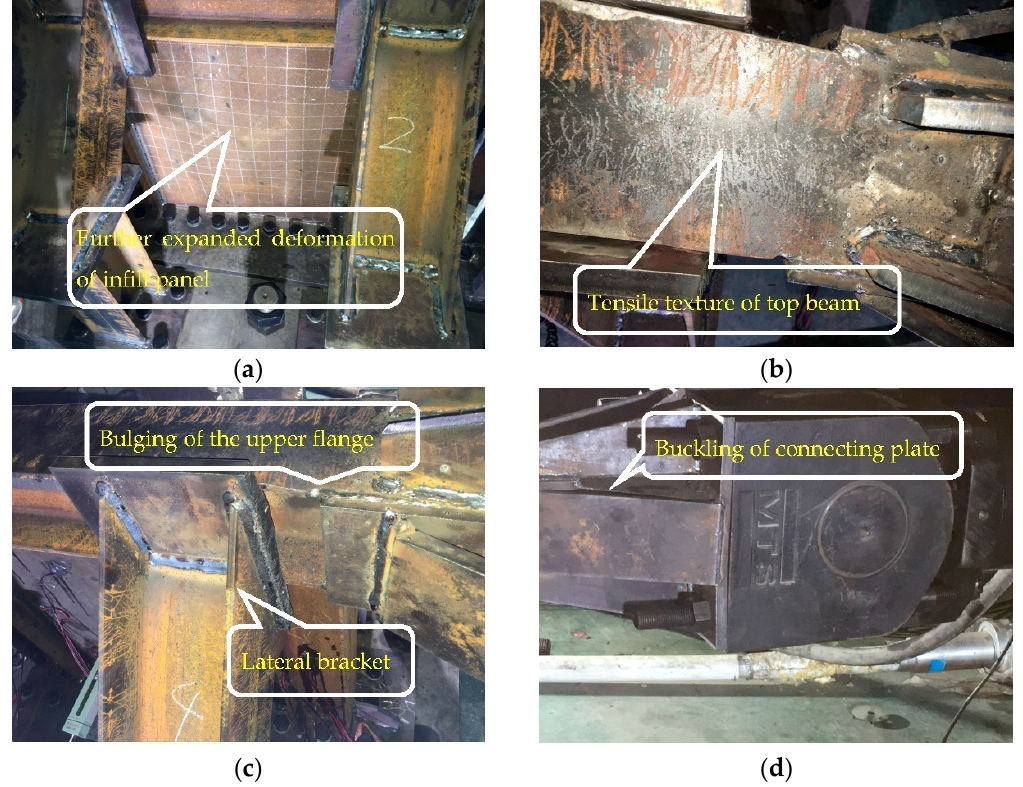
Figure 16. Deformation of structural members for specimen 1: ( a ) Infill panel; ( b ) Top beam; ( c ) Upper flange on the top beam; ( d ) Connecting plate.